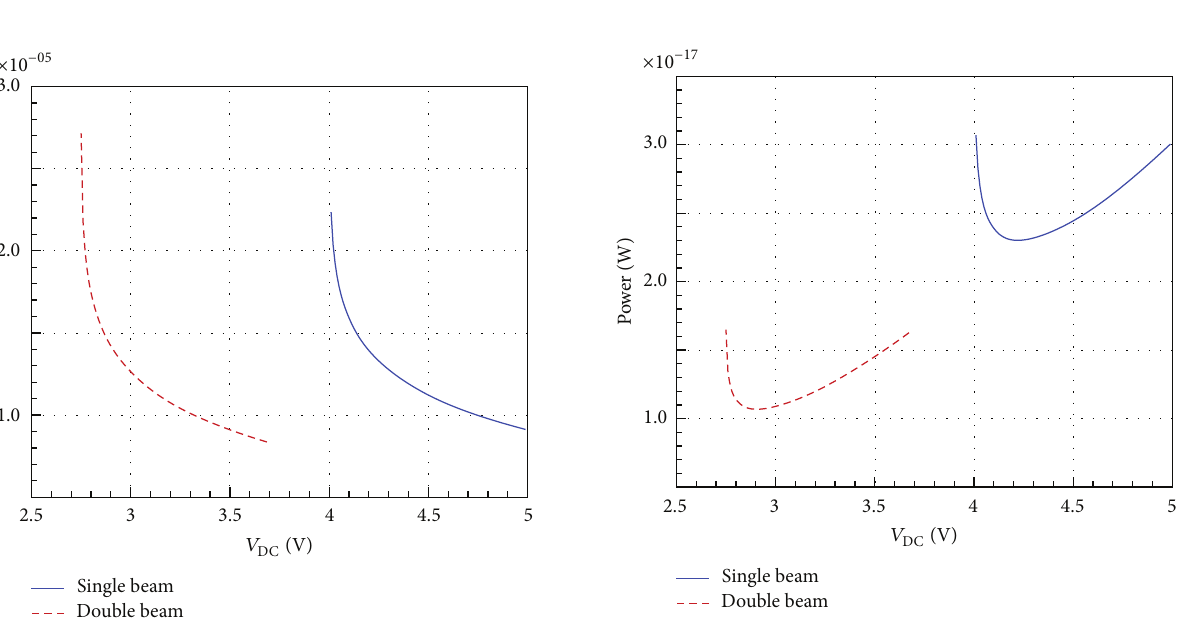
Figure 6: Influence of DC voltage on the electrostatic energy for simple and double beam microswitch designs.